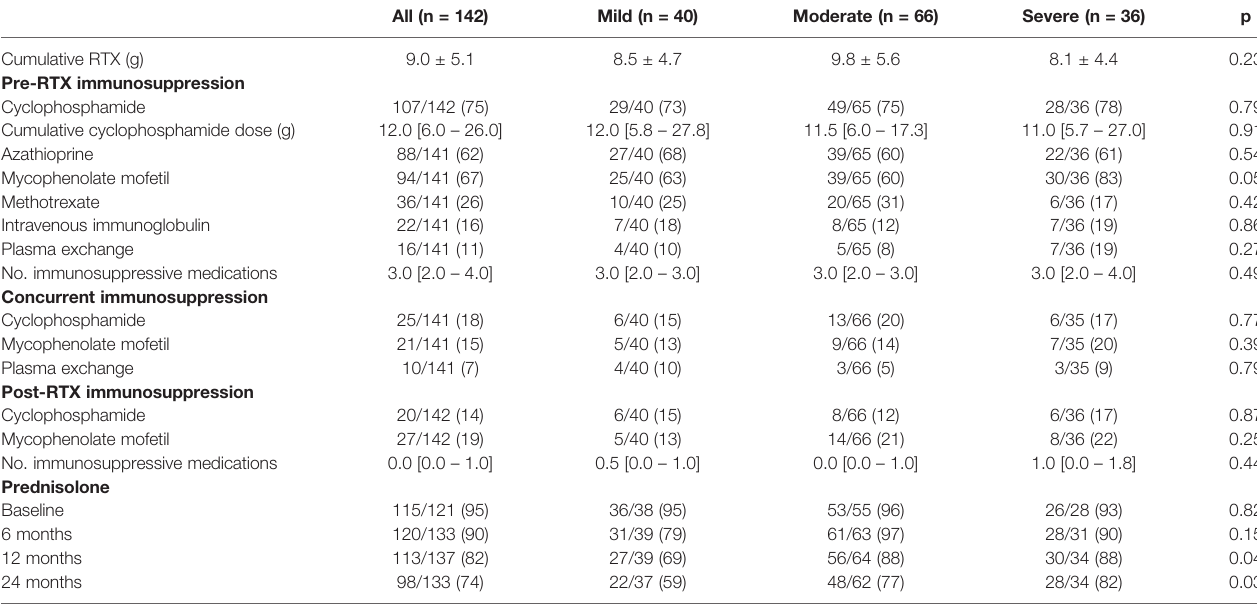
TABLE 2 | Use of immunosuppressive agents in patients with hypogammaglobulinemia.